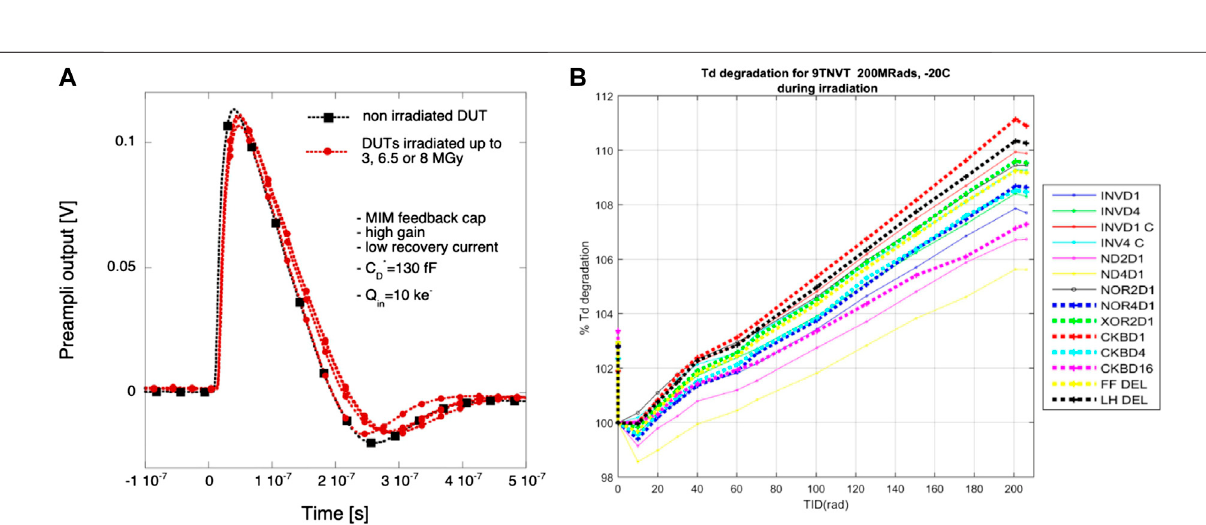
Frontiers in Physics |